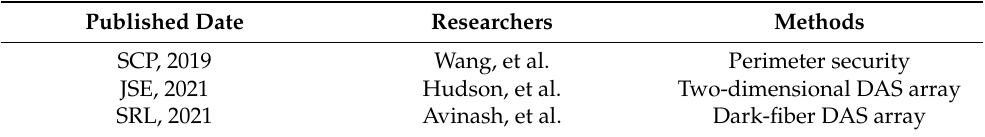
Figure 23. Beamforming results at channels 2000 – 3000 (subarray aperture 2 km) for an M4.3 earth- quake. ( a ) Record section showing filtered waveforms. ( b ) Vespagram (beam power in the 0 – 1 range as a function of slowness and time). ( c ) Traces from the top to bottom [81]. Table 8. Summary of earthquake monitoring applications.